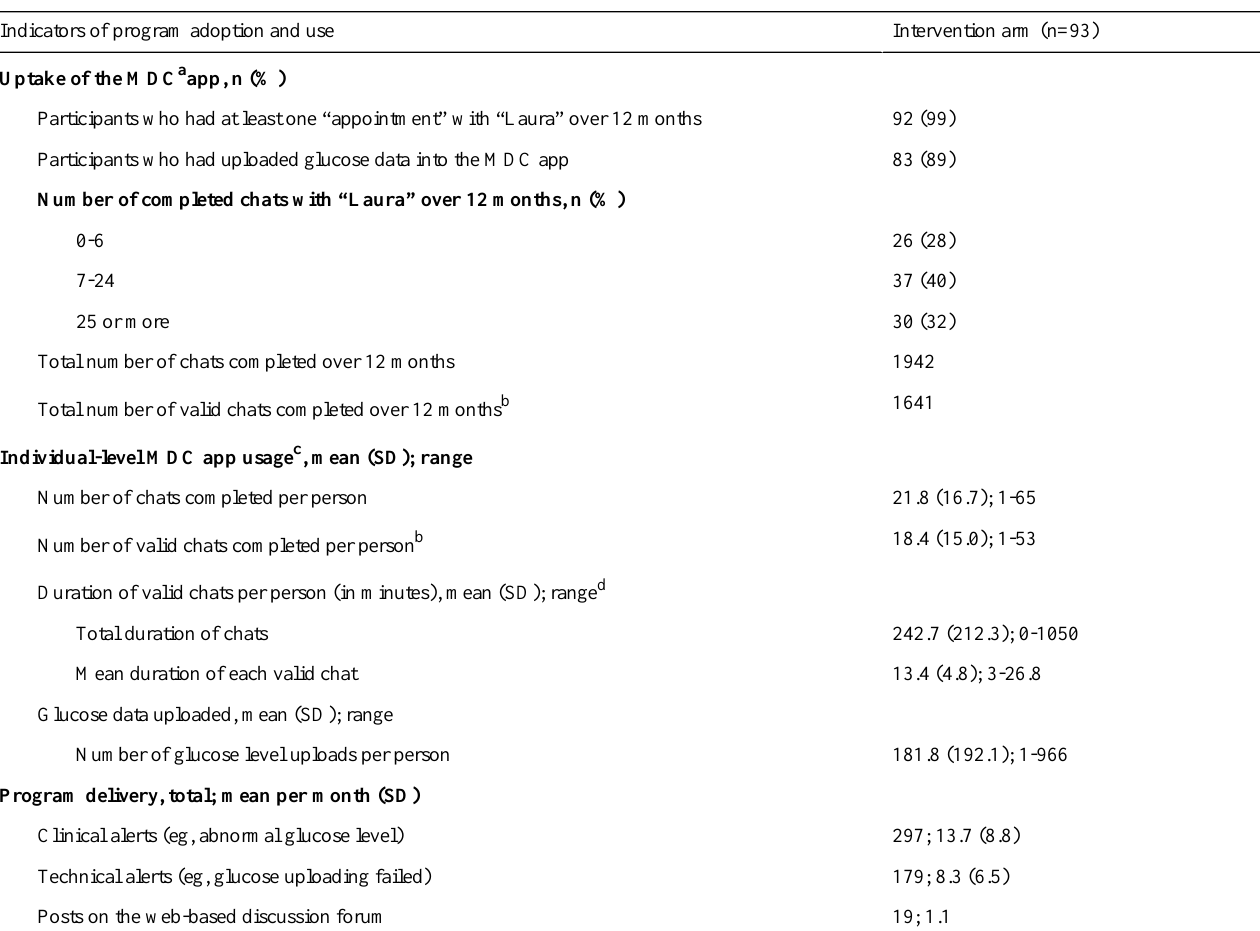
Intervention arm (n=93)Indicators of program adoption and use 92 (99)Participants who had at least one “appointment” with “Laura” over 12 months 83 (89)Participants who had uploaded glucose data into the MDC app